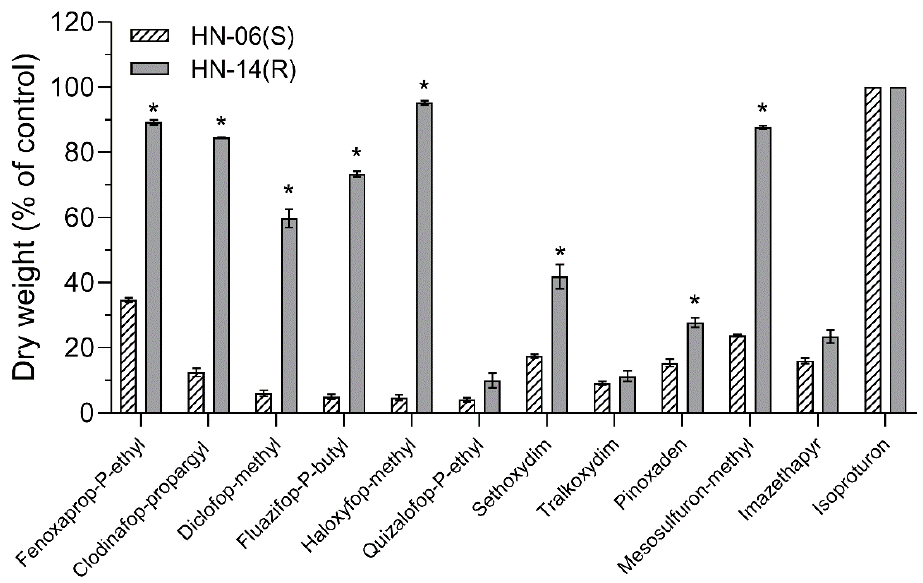
Figure 4. Herbicide sensitivity tests of S and R following treatments at the recommended rate. Note: *, significant difference ( p < 0.05) between the R and S populations. Bars are means ± SEM.